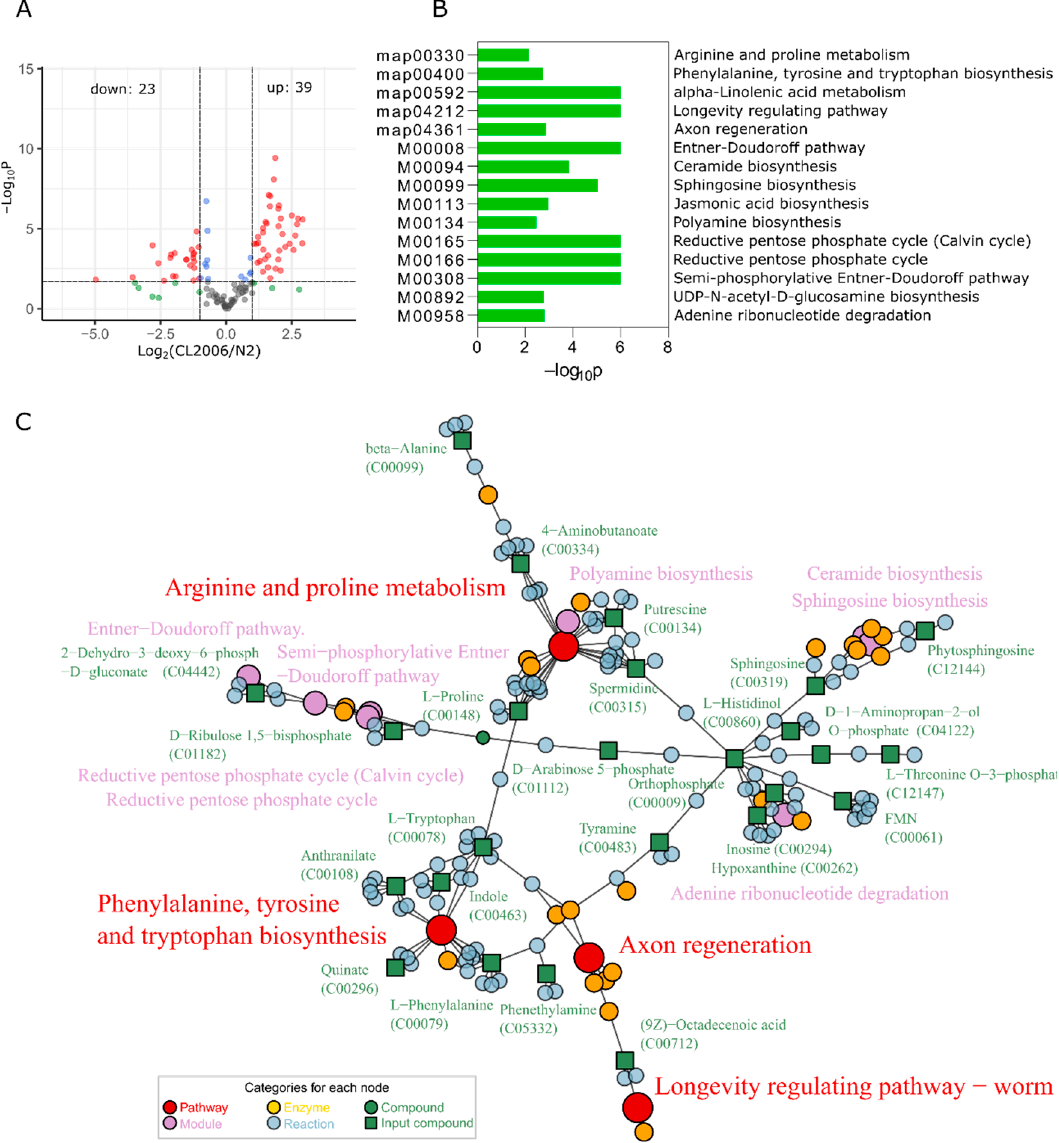
Figure 3. ( A ) Metabolite variation in the contrast CL2006 vs. N2 strains. Red scatter, FC > 2.0, p < 0.02; blue scatter, FC ≤ 2.0, p < 0.02; green scatter, FC > 2.0, p ≥ 0.02; grey scatter, FC ≤ 2.0, p ≥ 0.02. The relevant comparative data are shown in Table S2 in supplementary materials. ( B ) FELLA enrichment based on the differential metabolites. ( C ) Network relations of enriched KEGG nodes.